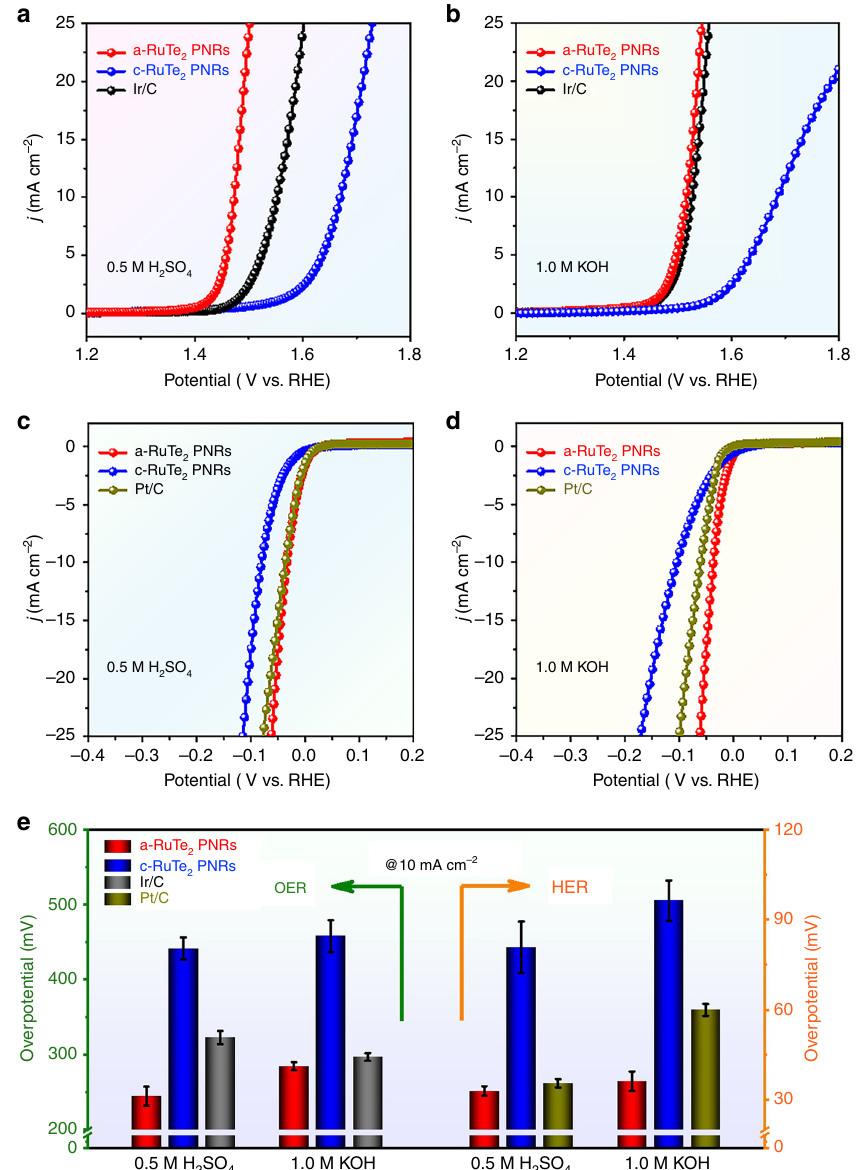
Fig. 6 Electrochemical studies of catalysts in different electrolytes. OER polarization curves of a-RuTe 2 PNRs, c-RuTe 2 PNRs and commercial Ir/C in a 0.5 M H 2 SO 4 and b 1.0 M KOH. HER polarization curves of a-RuTe 2 PNRs, c-RuTe 2 PNRs and commercial Pt/C in c 0.5 M H 2 SO 4 and d 1.0 M KOH. e Histogram of overpotentials at 10 mA cm − 2 from a – d